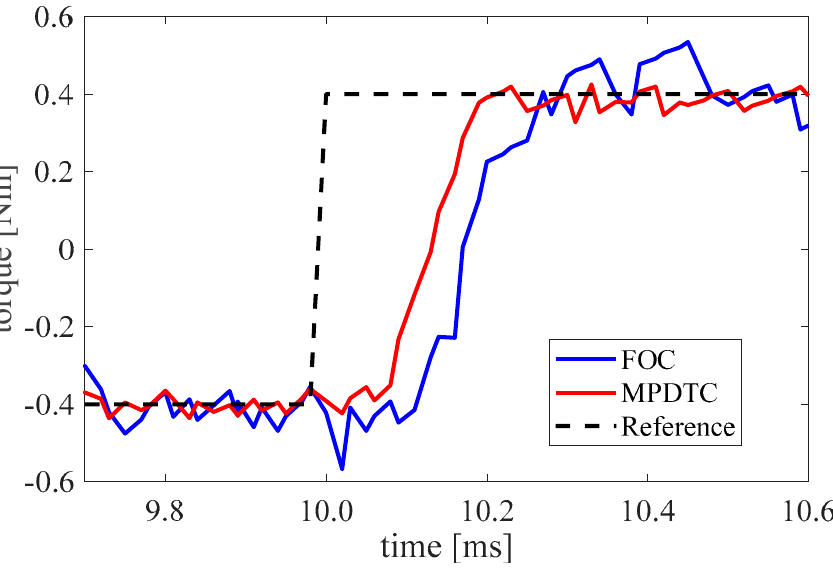
Figure 10. Comparison of the step response.